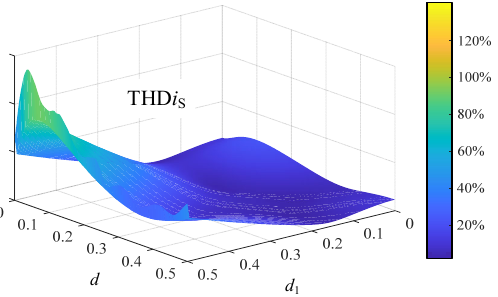
Figure 5. The relationship between phase shift ratio and THD i P with DPS modulation.